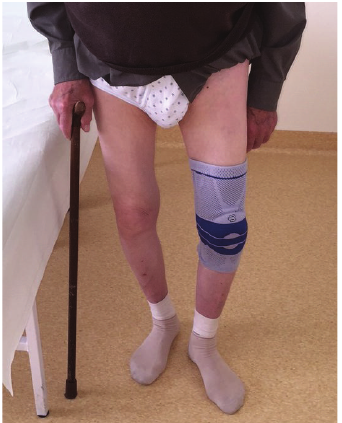
Figure 5: Two years and eight months after surgery. Patient is ambulatory using a walking stick.